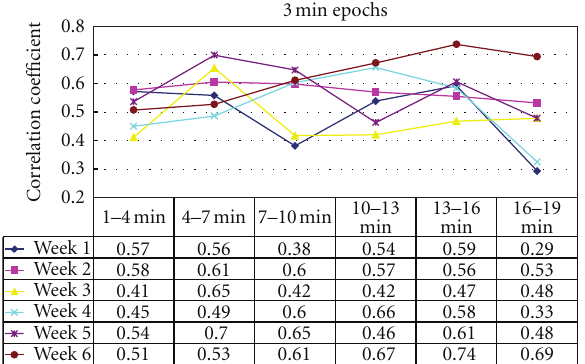
Figure 4: Pearson correlation coe ffi cients of 6 weeks for 3-minute epochs.